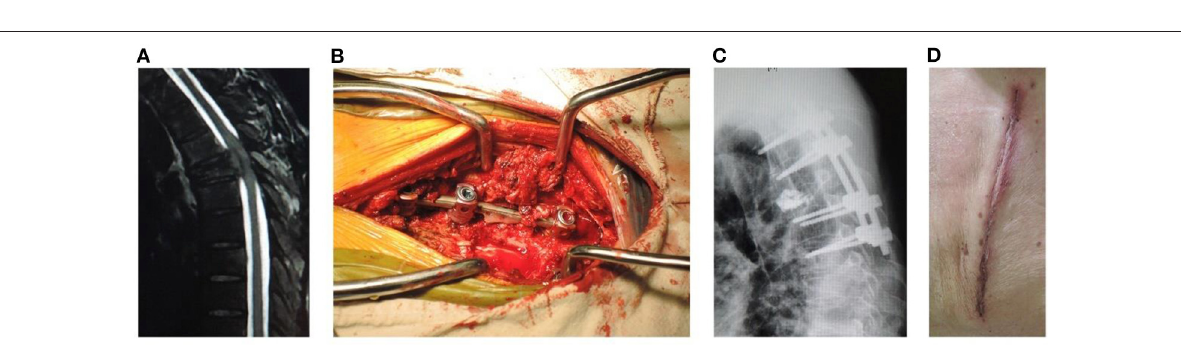
FIGURE 2 | A male patient of 53 years old with T5 metastasis and neurologic compression from HCC had back pain VAS 8, ASIA C, Tomita 7, modified Tokuhashi 12, ESCC grade 3, and SINS 14. He underwent open surgery for internal fixation, PVP, neurologic decompression, and partial tumor resection, with an operation duration of 180min, intraoperative blood loss of 800ml, incision length of 14cm, and stay in hospital of 11 days. (A) Sagittal MRI showed metastasis of T5 with neurologic compression. (B) Intraoperative photography. (C) Sagittal X-ray showed that the position of pedicle screws was good and no leakage of cement into the spinal canal occurred. (D) Incision after open